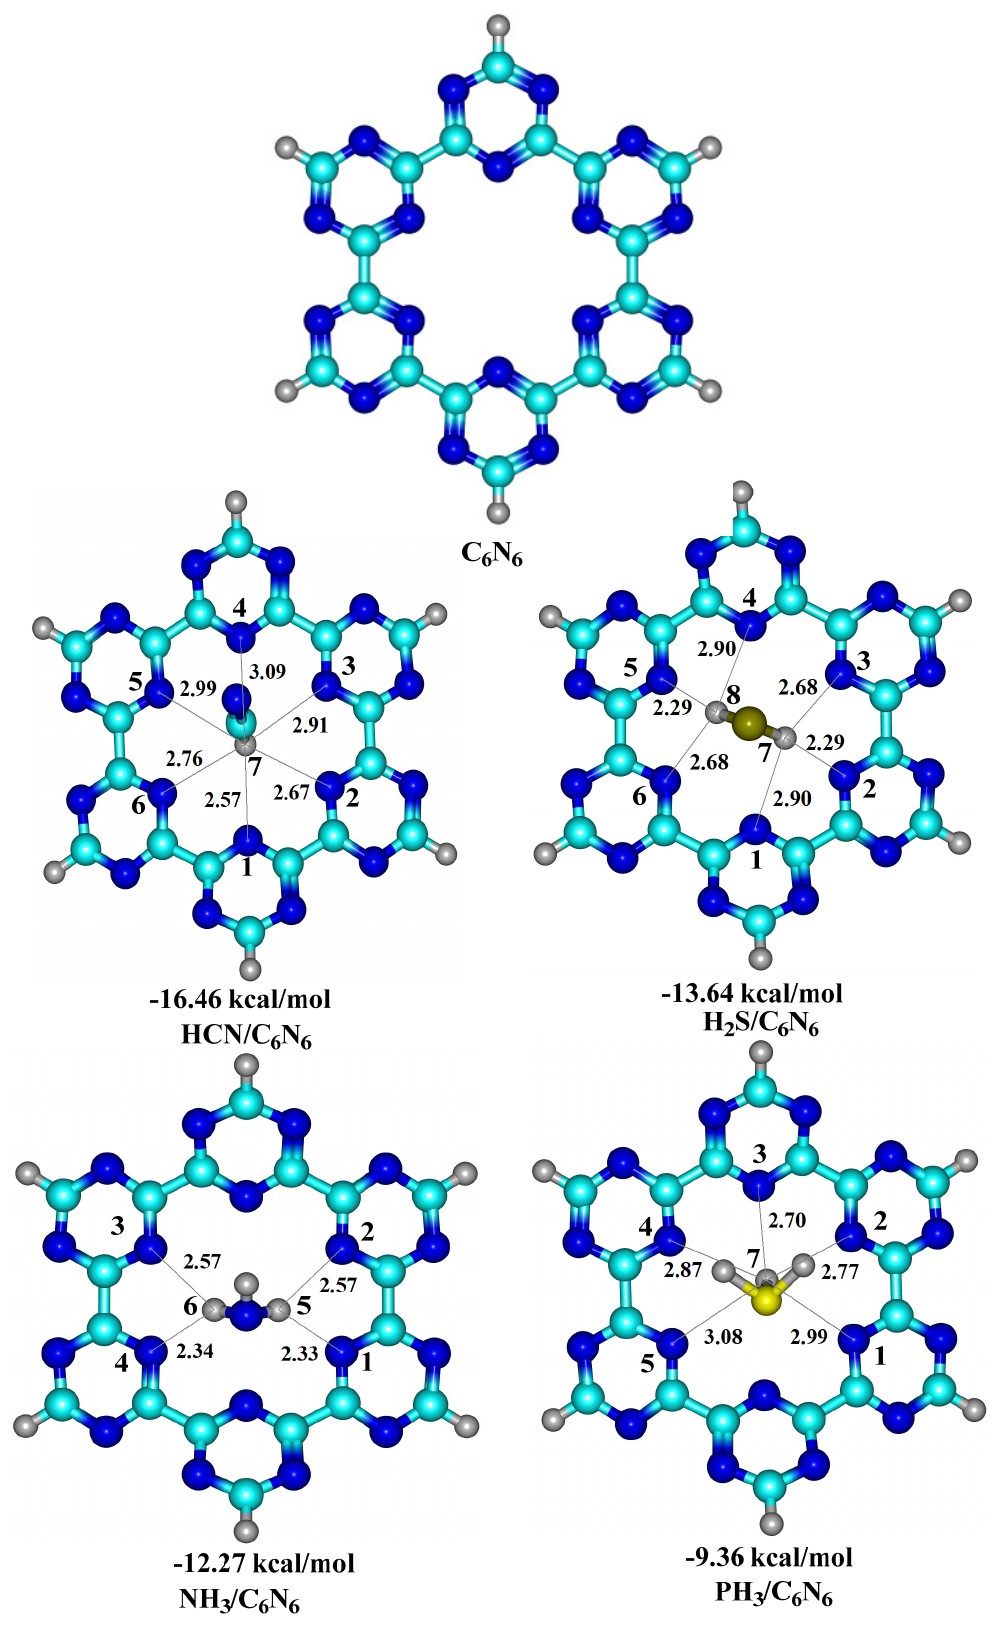
Figure 2. Top view of optimized structures of the analyte@C 6 N 6 complexes at the Ꞷ b97XD/6-31G (d,p) level of theory.